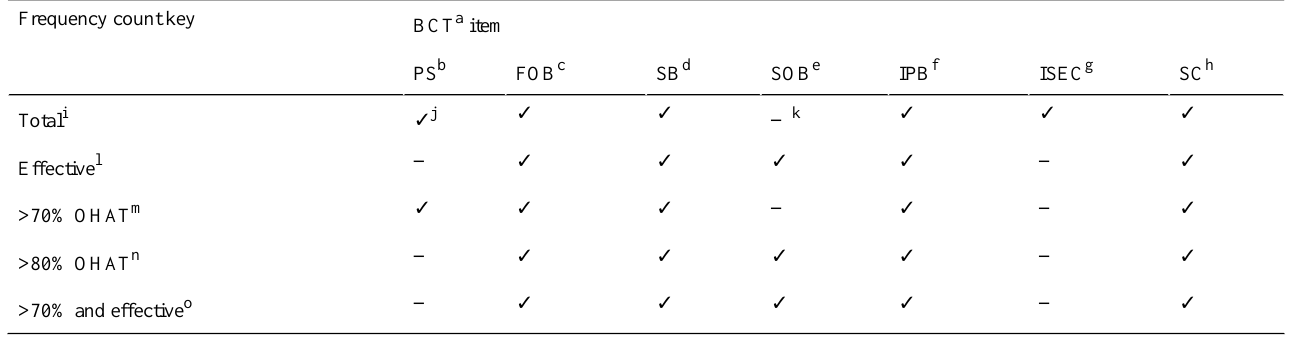
Table 1. A summary table of the behavior change techniques identified in frequency counts.